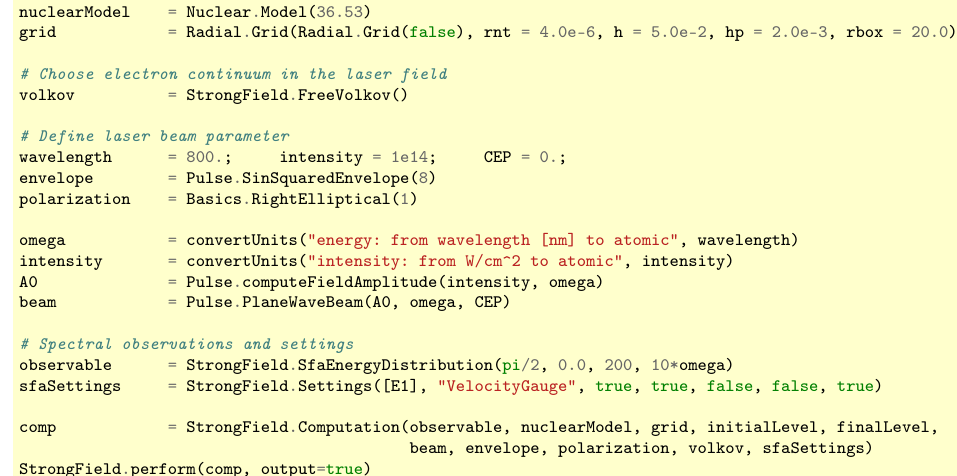
Figure 4. Julia input for generating the black-solid ATI spectrum in the left panel of Figure 5 for a krypton target, if irradiated by an n p = 8 cycle sin 2 laser pulse with a central wavelength of λ = 800 nm and intensity I = 10 14 W/cm 2 . The laser pulse is right-circularly polarized and has a carrier-envelope phase φ ( CEP ) = 0. This input describes the complete strong-field computation, but where the 4 p 6 1 S 0 ground and the final 4 p 5 2 P 1/2,3/2 levels of krypton are assumed to be generated before by the J AC toolbox. Although no attempt is made to explain this input in all detail, this figure nicely demonstrates